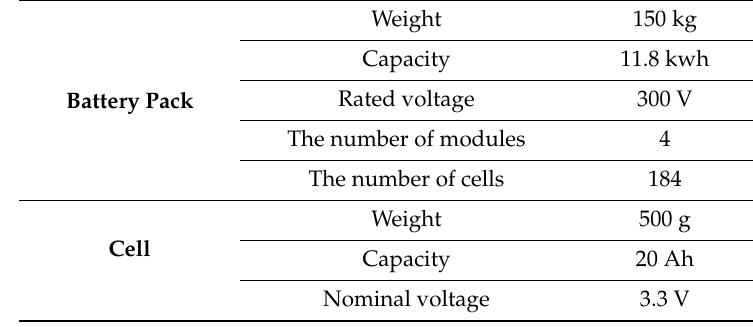
Table 1. The technical parameters of battery pack and cell.